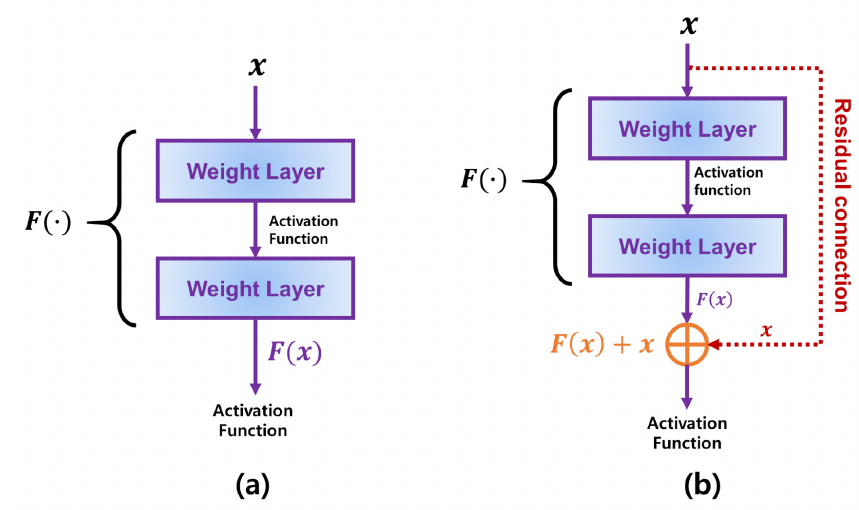
Figure 2. The comparison between the general connections and the residual connections used in ResNet. ( a ) describes how the input data x is passed into the weight layers in general CNN models with no residual connections. ( b ) shows how x is passed to both the weight layers and the residual connections in